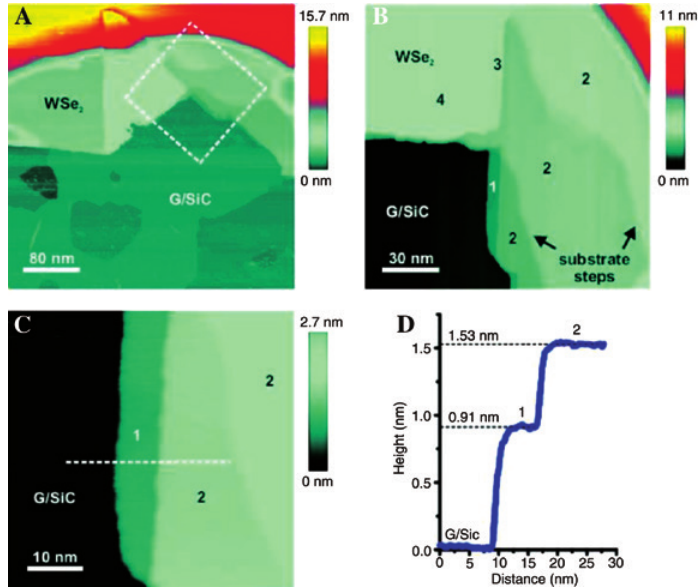
flake transferred on top of graphene (G) grown on silicon carbide 2 monolayer at the perimeter of the flake. 2